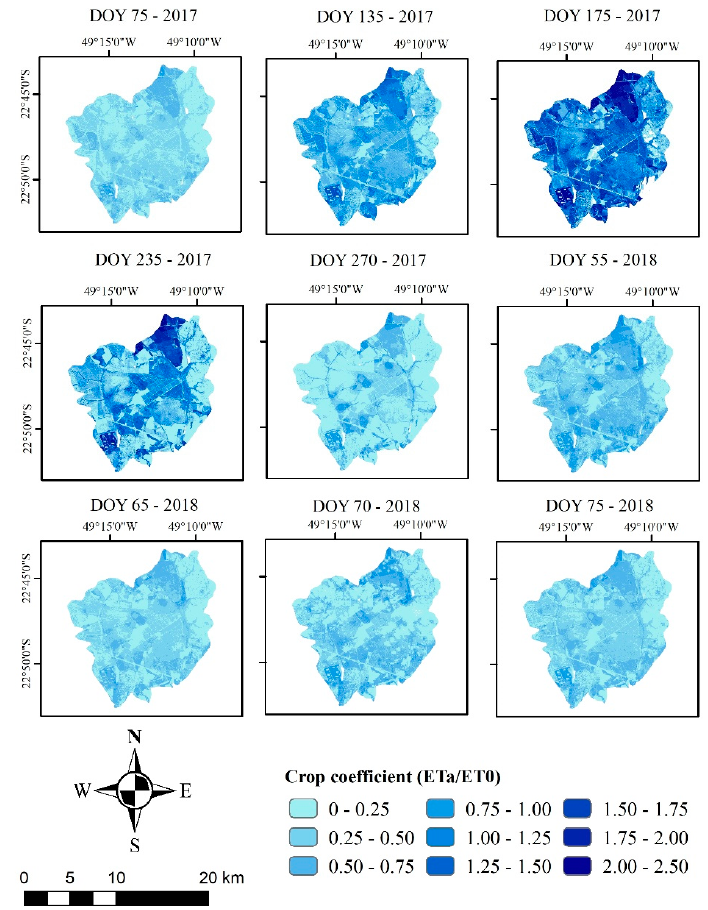
Figure 9. Crop coefficient between 2017 and 2018 in watersheds with varied land use (DOY = day of year). Table 5. Mean values and standard deviation of the crop coefficient between 2017 and 2018 by land use and day of year (DOY).